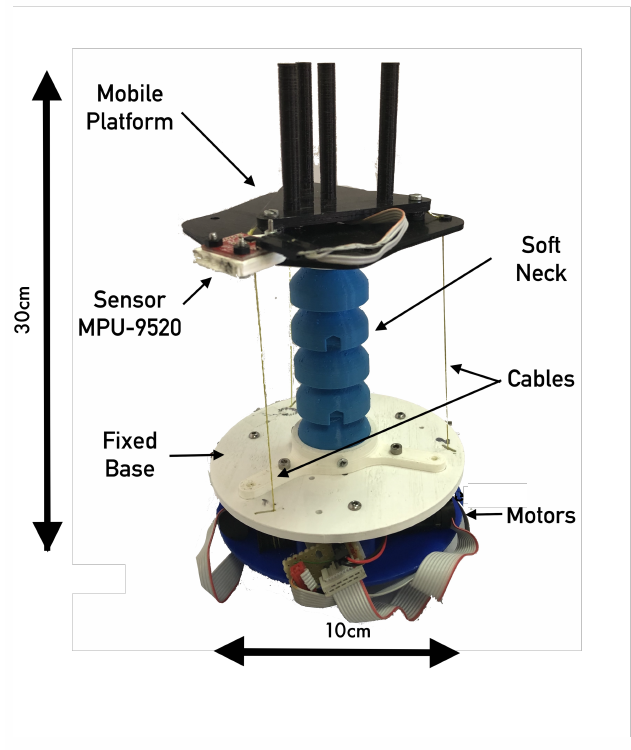
Figure 1. Soft neck platform.